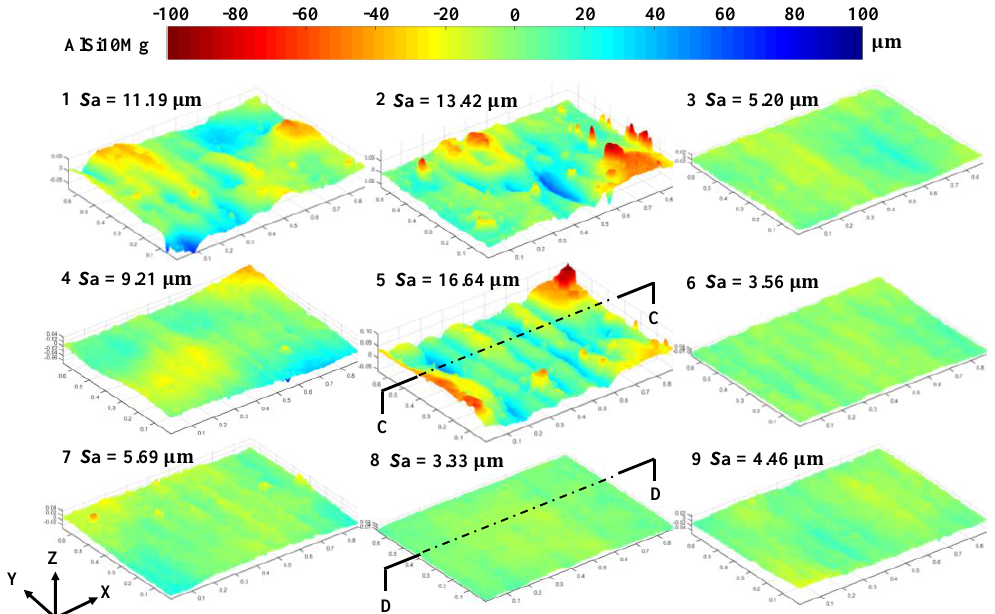
Figure 4. Three-dimensional contours of the Ti6Al4V sample after laser polishing.